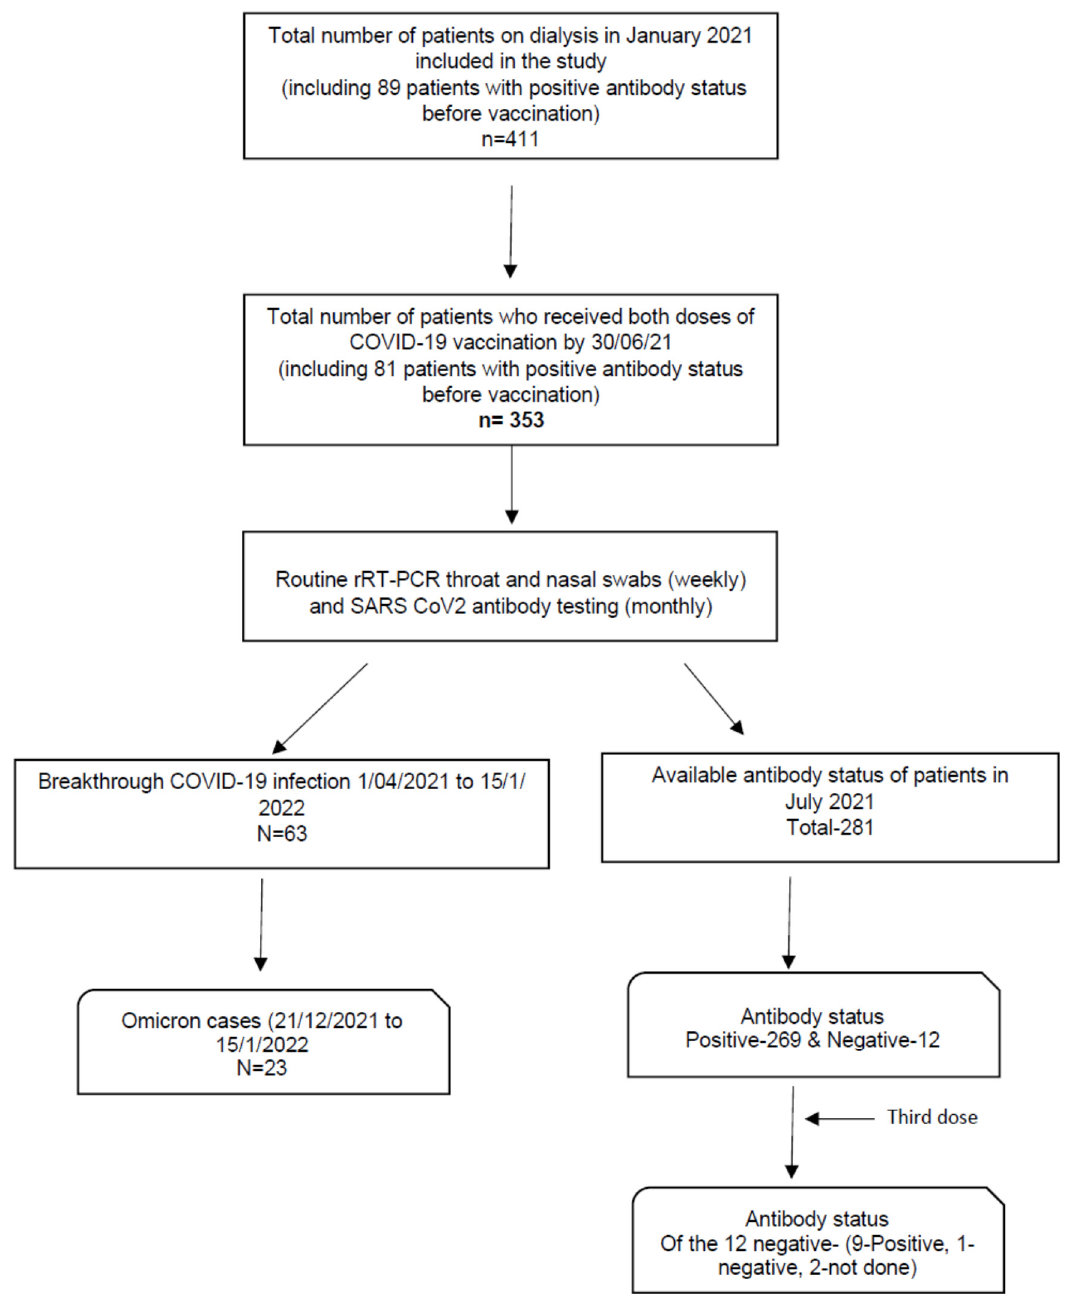
Figure 1. Flowchart for patient recruitment to the study.